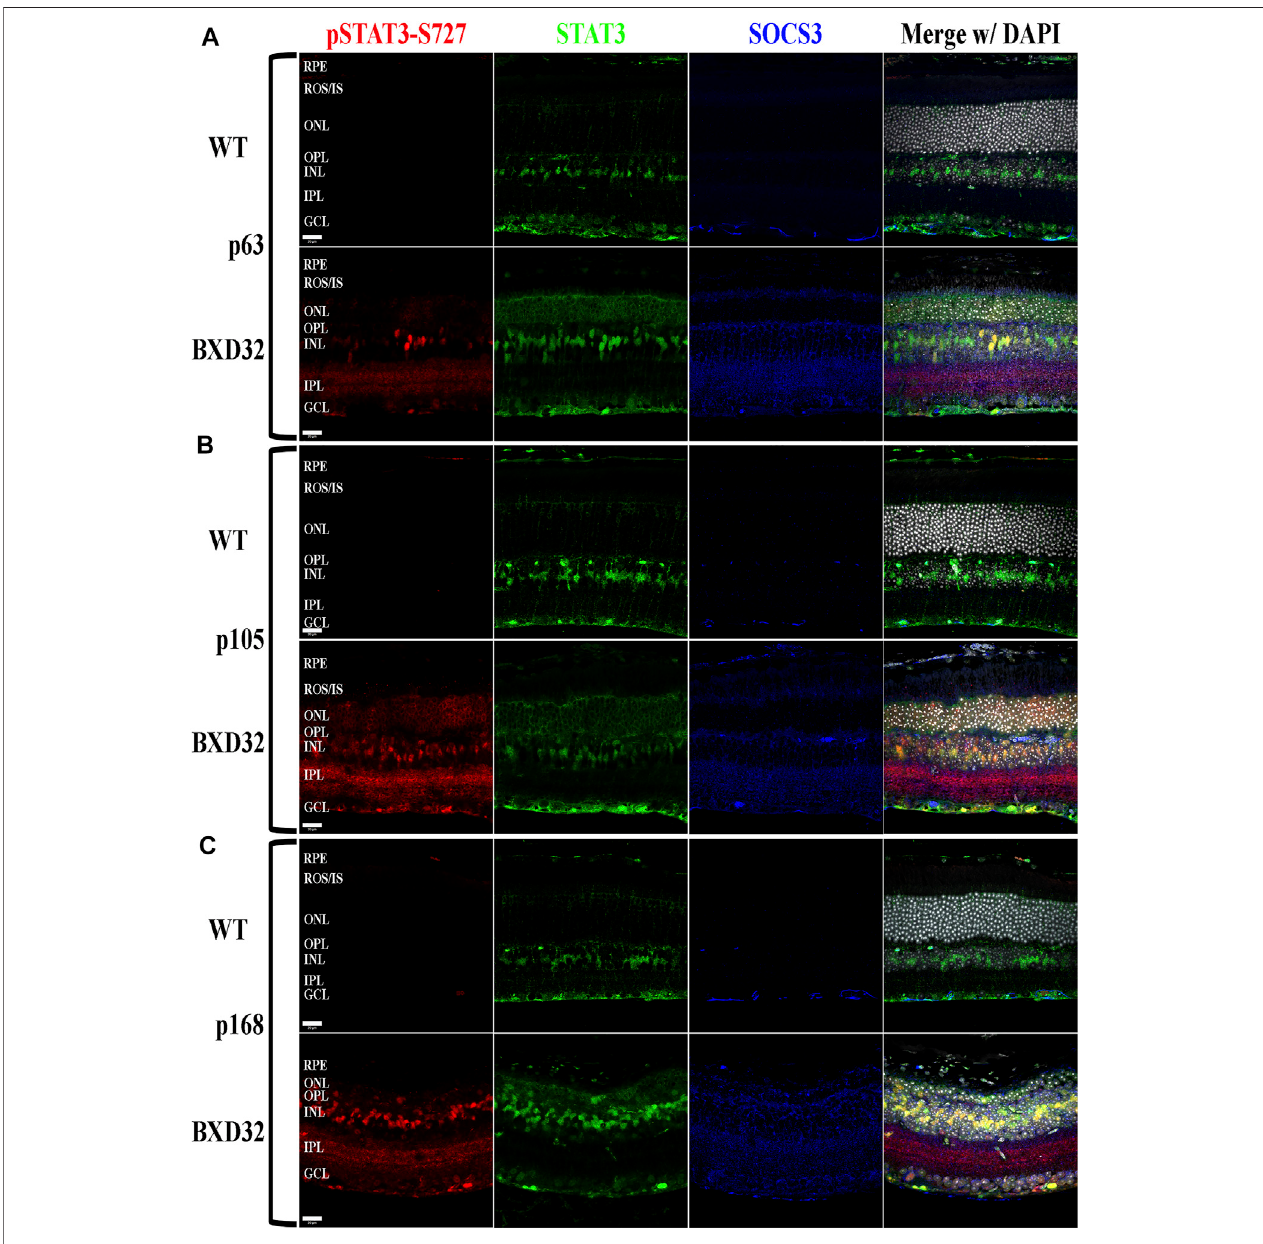
FIGURE 9 | BXD32 mouse retinas also exhibit STAT3 phosphorylation at serine 727, a multifunctional phosphorylation site. Using immunolabeling for pSTAT3 at serine 727 (pSTAT3-S727, red), total STAT3 (green), and SOCS3 (blue), it is observed that BXD32 retinas have excessive phosphorylation on STAT3-S727, a phosphorylation site serving multiple functions, two of which are the initiation of dephosphorylation of Y705, the inactivation step of STAT3, and upregulation of the mRNA for SOCS3. This upregulation can be observed in p63 (A) , p105 (B) , and p168 (C) retinas. The upregulation of both STAT3 and SOCS3 can also be observed in these sections. Nuclei stained with DAPI (white/grey). RPE, retinal pigment epithelium; ROS/IS, rod outer segments/inner segments; ONL, outer nuclear layer; OPL, outer plexiform layer; INL, inner nuclear layer; IPL, inner plexiform layer; GCL, ganglion cell layer. Scale bars = 20 μ m.